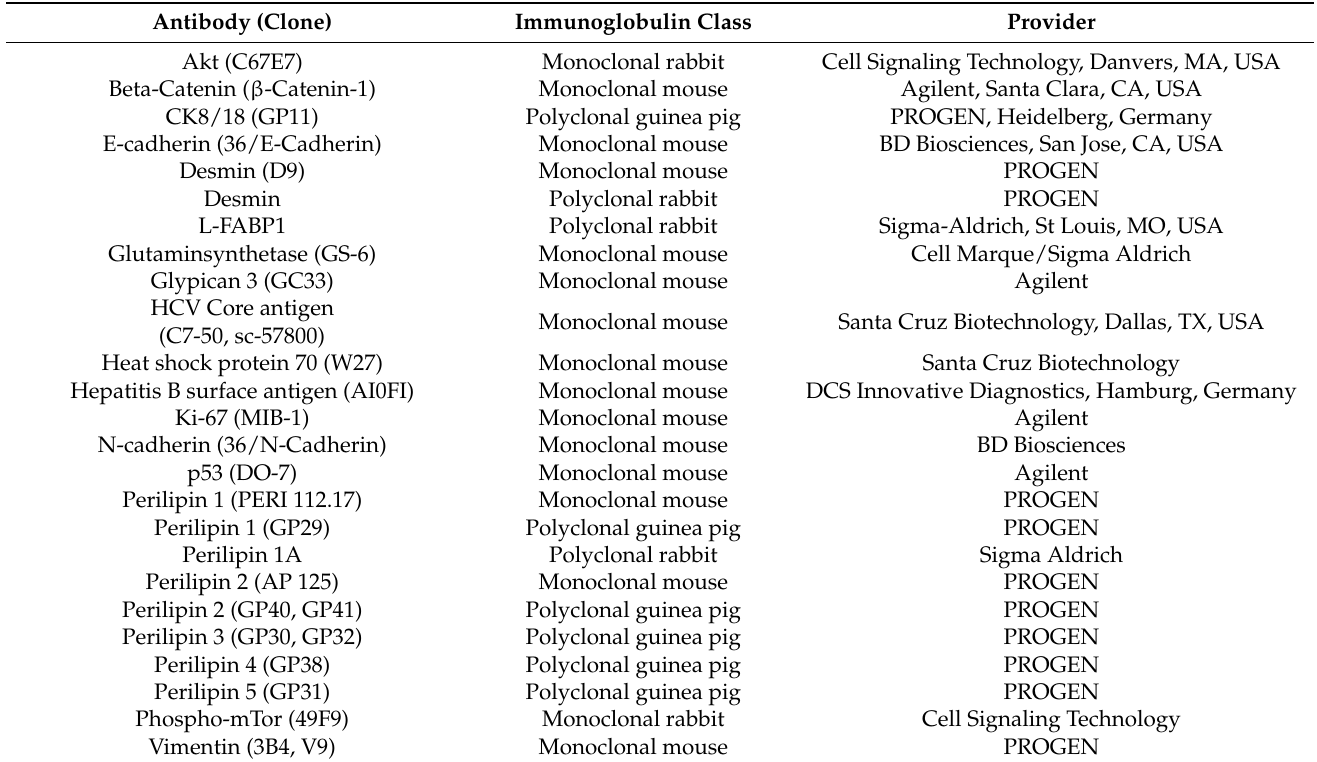
Table 3. Antibodies used for immunohistochemistry and immunofluorescence